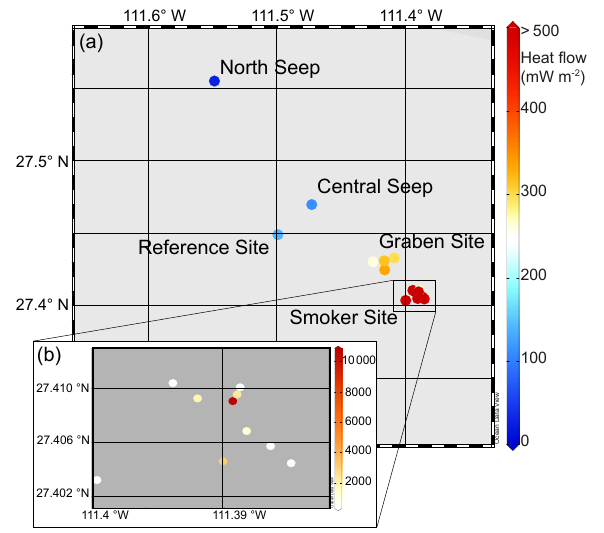
Figure 3. (a) Heat flow in the vicinity of the northern trough. Note the different heat flow scale in the enlarged area of the Smoker Site (b)